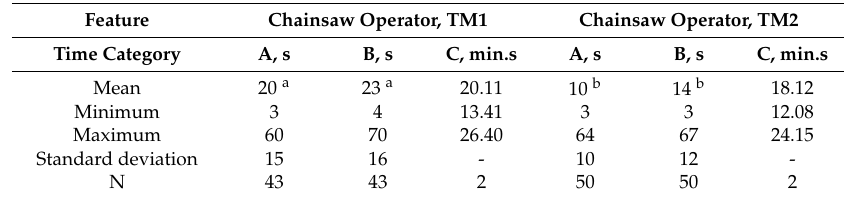
Table 8. Chainsaw operator time consumption per tree; Mann-Whitney U test and descriptive statistics of time categories.